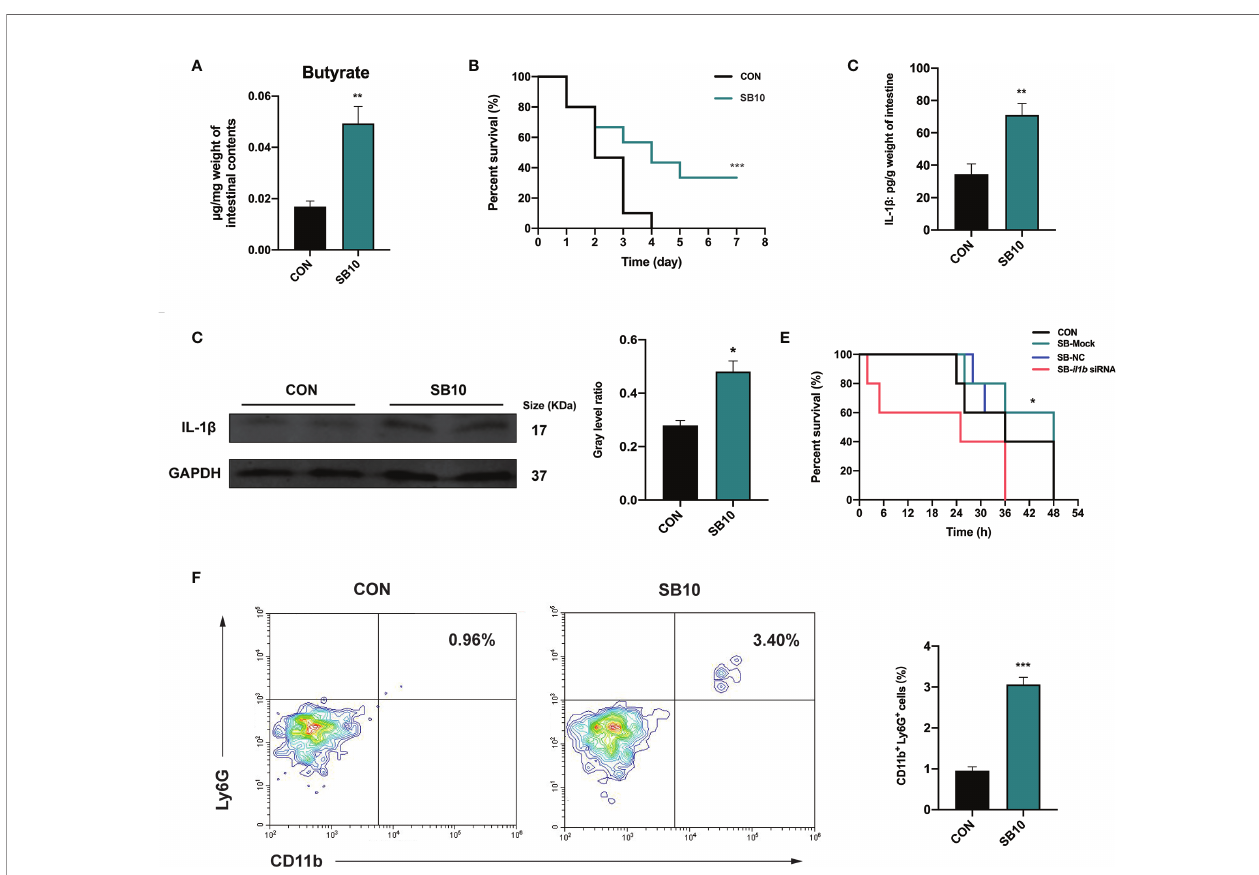
FIGURE 5 | Sodium butyrate addition shows similar protective effect of P. pentosaceus YC in pathogen resistance on zebra fi sh. (A) Intestinal butyrate levels of zebra fi sh fed on commercial diet supplemented with 0 mmol/kg (CON) and 10 mmol/kg (SB10) sodium butyrate ( n = 3). (B) Survival curve of zebra fi sh from CON and SB10 groups following 10 8 CFU/ml A. hydrophila challenge. Each curve represents the sum of three independent tanks. *** p < 0.001 by Mantel – Cox test. (C) ELISA analysis of intestinal IL-1 b level of zebra fi sh from CON and SB10 groups ( n = 6). (D) Representative Western blot of intestinal IL-1 b of zebra fi sh from the CON and SB10 group. (E) Survival curve of zebra fi sh following 10 9 CFU/ml A. hydrophila challenge. Zebra fi sh were pretreated with 10 mmol/kg sodium butyrate for 1 week and then gavaged with PBS (SB-Mock), 50 µM non-targeting (SB-NC), or il1b (SB- il1b siRNA) siRNA. Asterisks indicate signi fi cant differences between SB- Mock and SB- il1b siRNA. * p < 0.05 by Mantel – Cox test. (F) Flow cytometry analysis of zebra fi sh intestinal neutrophils stained with anti-CD11b and anti-Ly6G antibodies ( n = 3). Numbers indicate the percentage of CD11b + Ly6G + neutrophils in intestinal cells. Data are represented as mean ± SEM. * p < 0.05; ** p < 0.01; *** p < 0.001 by Student ’ s t